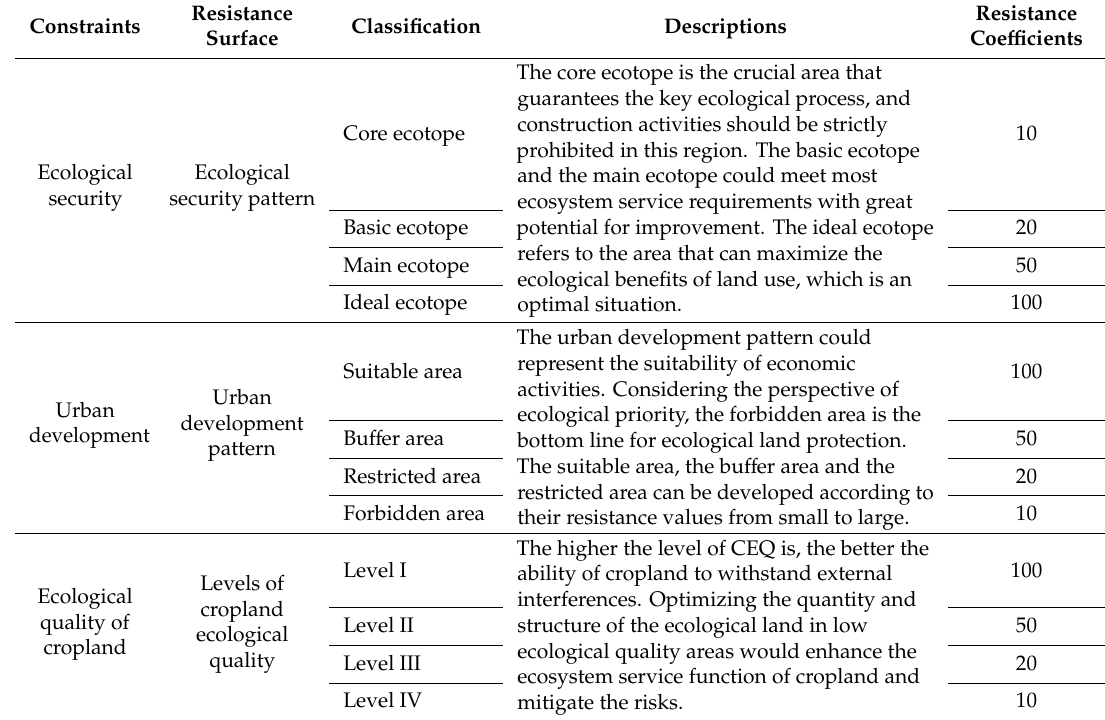
Table 1. Single resistance surface classification and resistance coe ffi